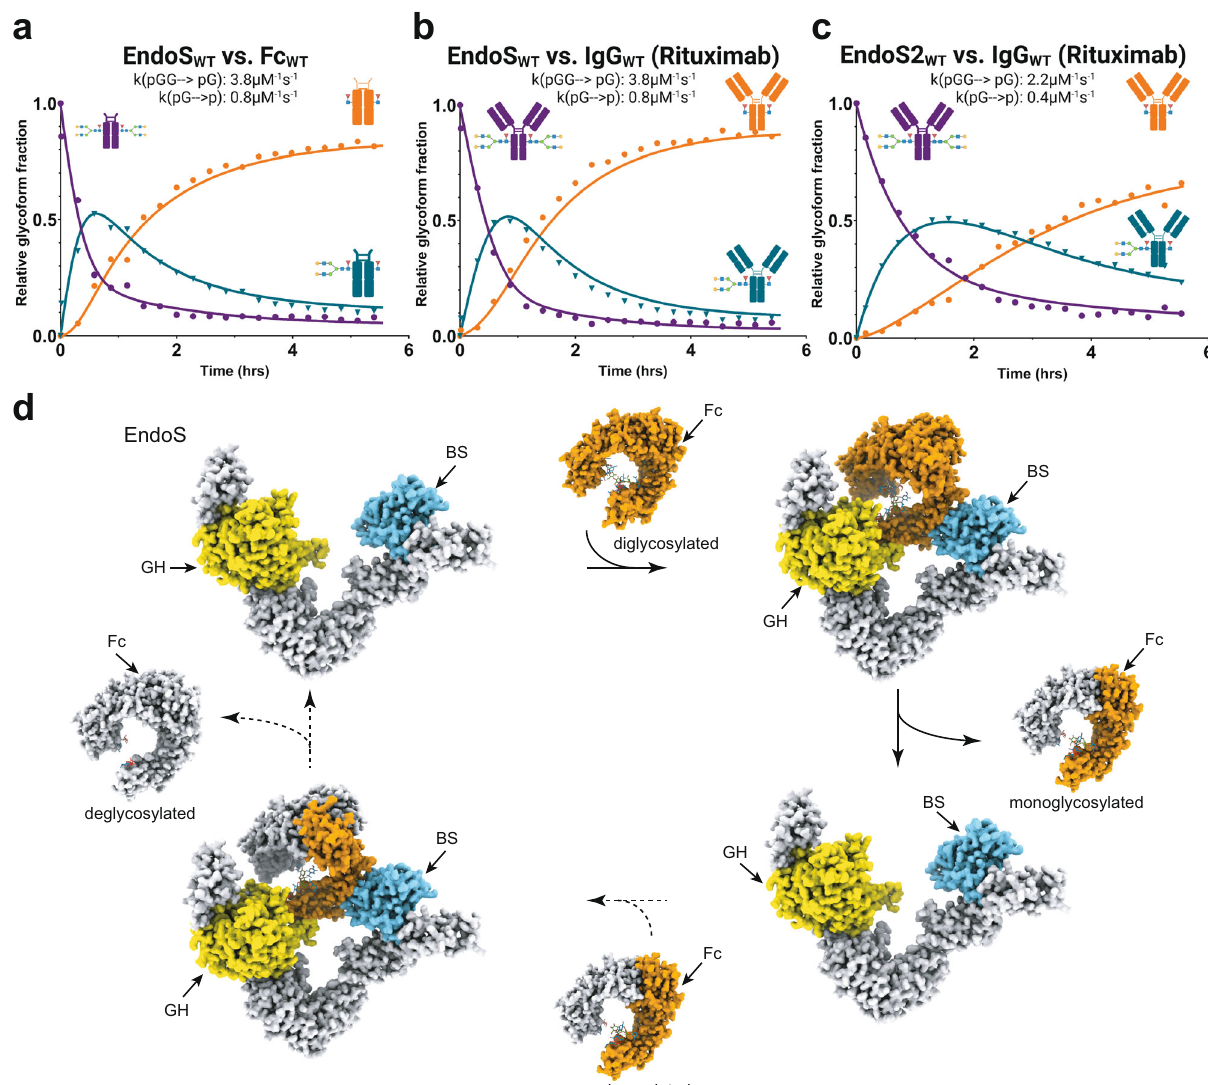
Fig. 5 | Molecular mechanism of antibody recognition by EndoS and EndoS2. Kinetic modeling of deglycosylation of ( a ) Fc WT and ( b ) IgG WT by EndoS WT and ( c ) IgG WT byEndoS2 WT .LC-MSkineticanalysisofdeglycosylationofFc WT andIgG WT by EndoS WT showing the hydrolysis over time of the two N -glycans linked to Asn297. Thedeglycosylationprocessoccurssequentiallyasseenbytheinitialincreasethen decrease in monoglycosylated population (dark green) over time while the